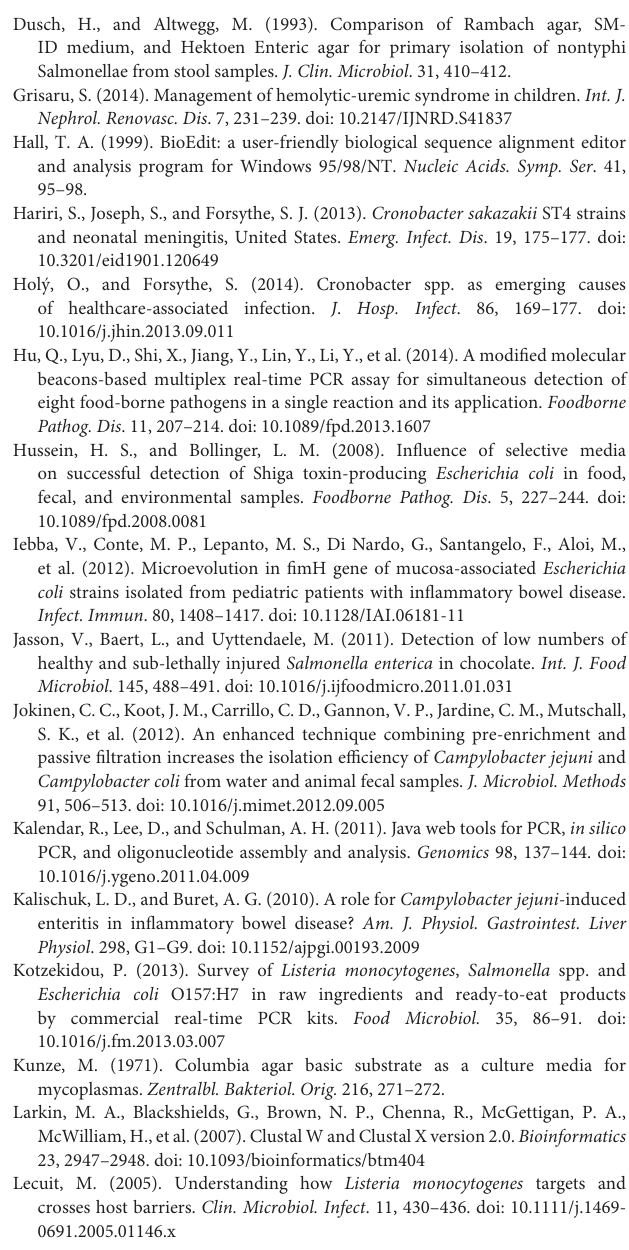
Figure S1 | Agarose gel electrophoresis for testing gDNA specific amplification from pre-enrichment cultures on GVUM, using 19 types of food matrixes contaminated with. (1) C. jejuni (showing triplicate PCR experiments); (2) E. coli ; (3) F. Enterobacteriaceae (in this case K. pneumoniae ); (4) St. aureus (showing three replicates); (5) Salmonella spp. (in this case Sa. enteriditis CECT-556); (6) L. monocytogenes ; (7) B. cereus ; (8) Cl. perfringens ; (9) Cr. sakazakii . CR, Fresh meat; P, Chicken; S, Sausages; F, Fish; CF, Canned fish; SF, Fish consommé; LC, Raw milk; Y, Yogurt; N, Cream; LP, Powder milk; Fi1, Infant formula 1; Fi2, Infant formula 2; HC, Eggs; V, Vegetables; M, Honey; W/O, GVUM control without matrix; C+, gDNA PCR positive control; C–, No template control.